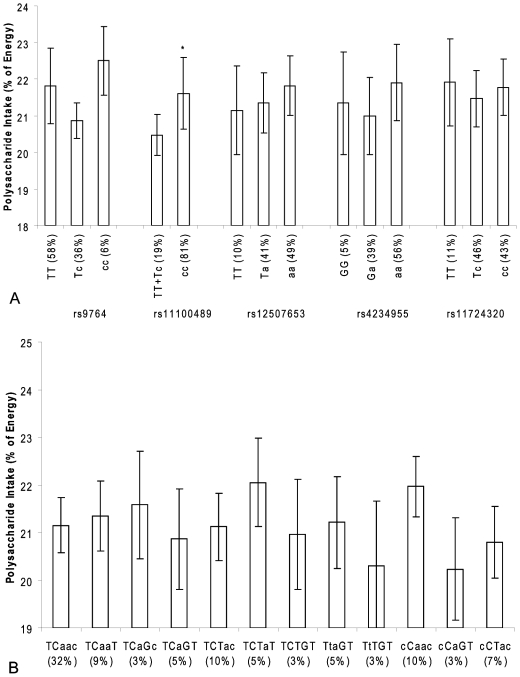

NPY1R/NPY5R variants and polysaccharide intake in the Hamlet population.Figure 4a shows the association of SNPs in the NPY1R/NPY5R region with polysaccharide intake as percentage of total energy intake. The ancestral alleles are indicated as capital letters.*p<0.05(compared with linear regression model) Figure 4b shows the association of NPY1R/NPY5R haplotypes with polysaccharide intake as percentage of total energy intake. The haploblocks consist of the SNPs rs9764, rs11100489, rs12507653, rs4234955 and rs11724320 and the ancestral alleles are indicated as capital letters. *p<0.05 (compared with linear regression model).